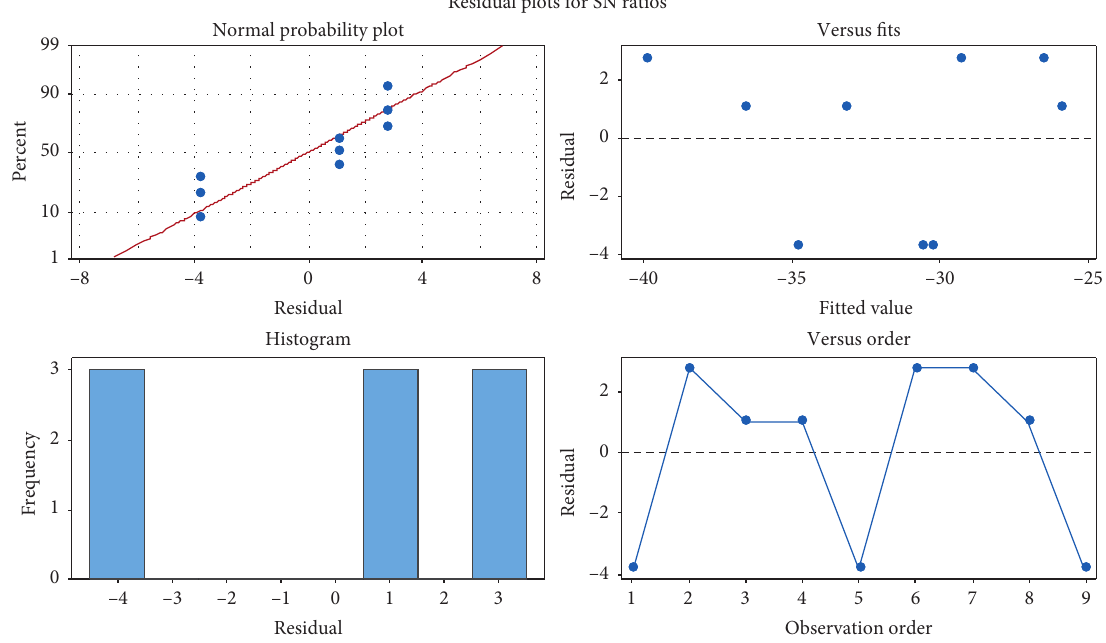
Figure 10: Thrust force-based residual plot of percent, frequency, fitted values, and versus